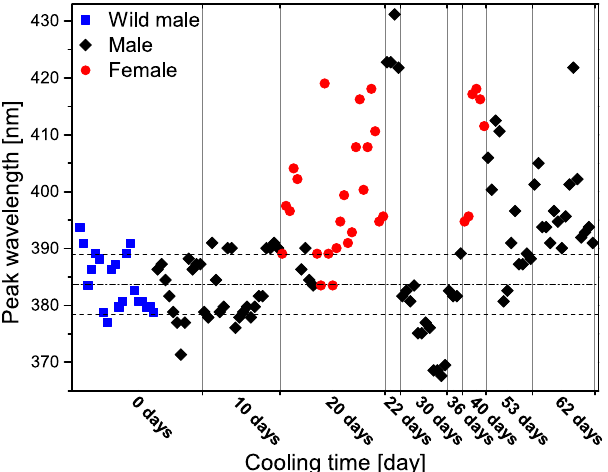
Figure 4. Spectral position of the blue reflectance peak for all the investigated exemplars. When possible all four wings of an individual are represented as individual measurement points close to the same vertical line. Horizontal broken lines indicate the range of wild males with centre at 384 nm marked by dotted broken line. The data of pupae cooled for a certain time are separated by thin vertical lines. We used only the wings sufficiently extended after eclosion to allow reliable spectral